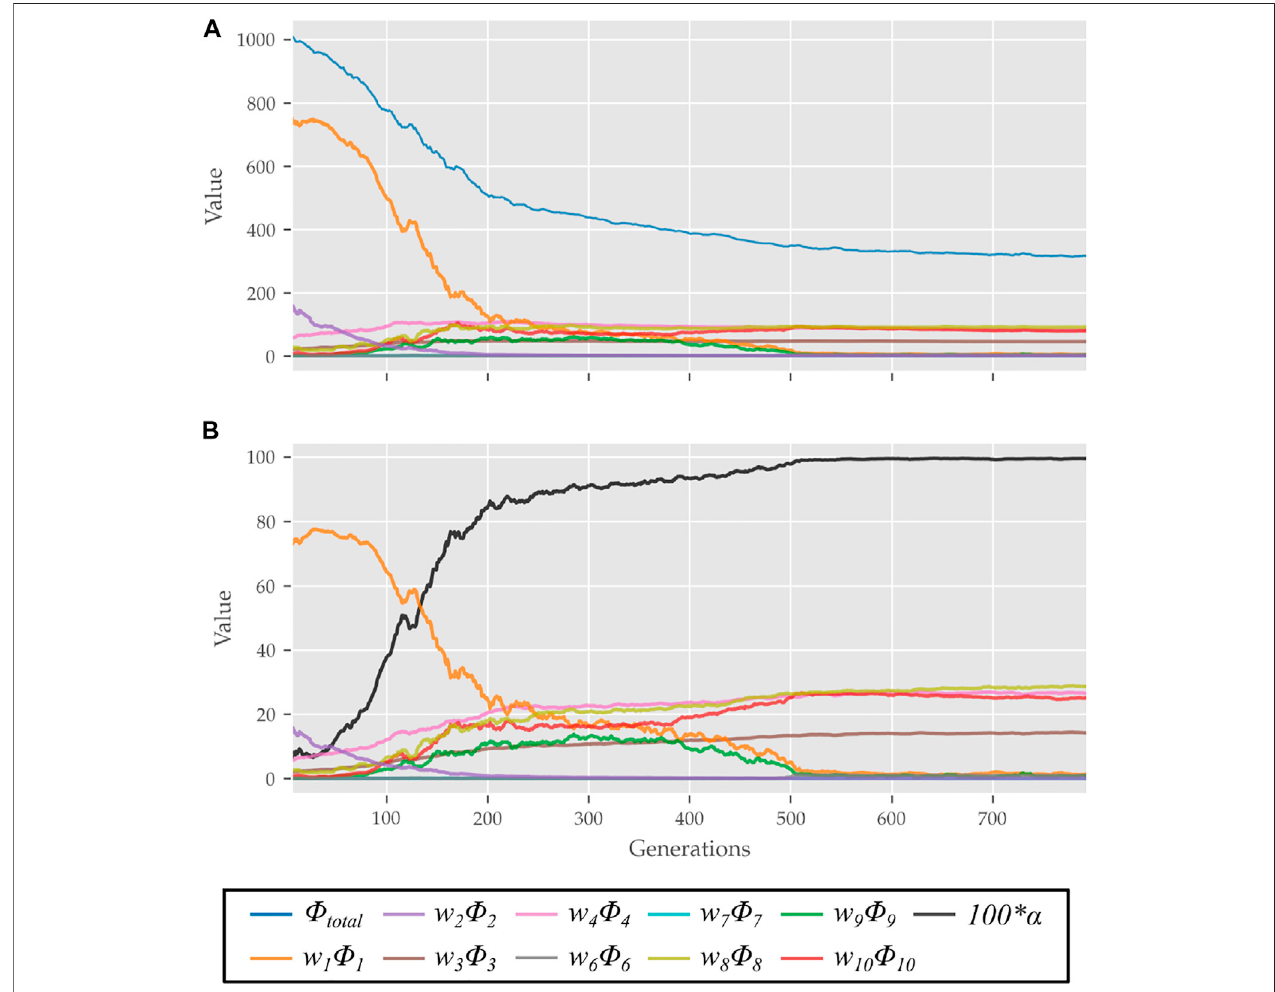
FIGURE 4 | (A) Evolution of different costs and (B) their relative contributions to the total cost for the best candidates observed during optimization using the 0% strength de fi cit model. The costs were smoothed using a rolling average of 10 generations for this plot.